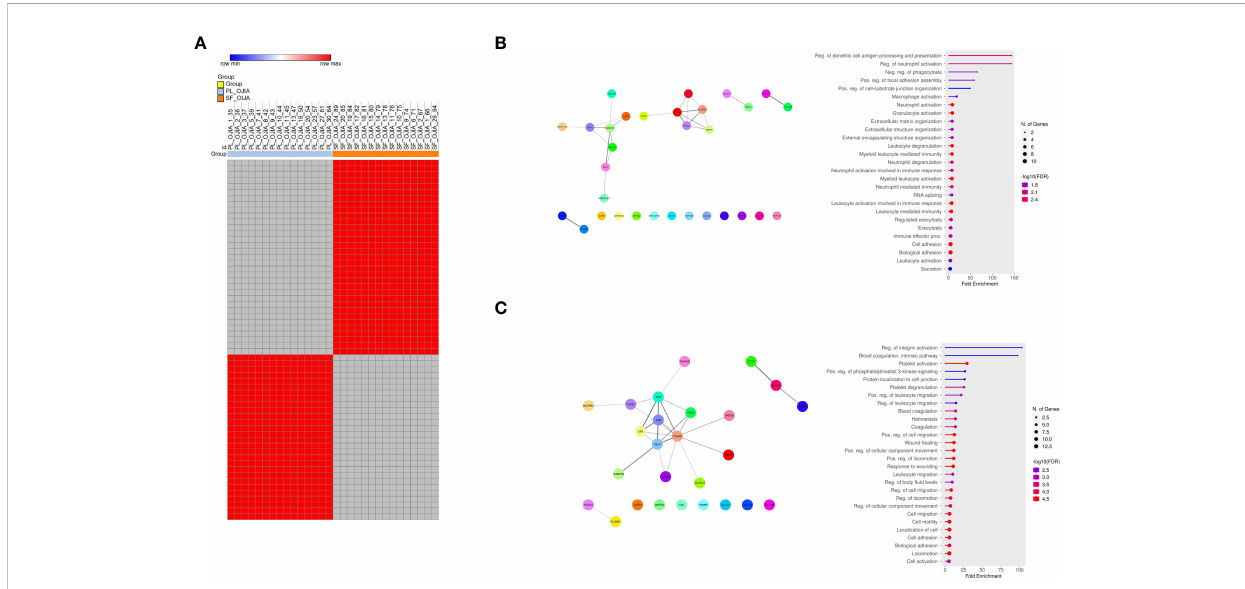
FIGURE 4 Analysis of the distribution of missing values in paired PL_OJIA vs SF_OJIA samples. Distribution of missing values between the fi fteen paired SF and PL samples was assessed by a matched pair binomial test. Exclusively expressed EV-prots were subjected to network and pathway analyses. (A) Heat-map representation shows detectable (red color) and missing values (gray color) across samples. Each column corresponds to a sample (indicated on the top side) and each row represents a differentially expressed protein derived from the comparison. The blue and red bars above the columns distinguish the SF and PL groups. Differences with p-value lower than 0.0001 were considered statistically signi fi cant. Heat-map was drawn using global coloring. A good association between clusters of EV-prot and the SF and PL groups of samples is shown. Protein designation was made according to the Uniprot database nomenclature, when available. The proteins in position 1 and 45, whose name is missing in the Uniprot database, have Uniprot ID number A0A182DWH4 and P09493-8, respectively. (B, C) Network and pathway enrichment analyses were carried out on EV-prots uniquely expressed in SF (B) and PL (C) samples. Functional interaction networks among EV-prots and GO enriched biological processes are depicted as detailed in the legend of Figures 3C,